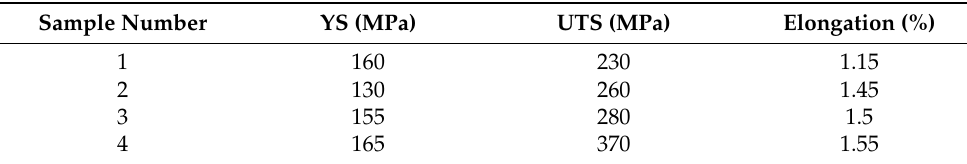
Figure 12. Stress–displacement curve of welded joints of the four samples. Table 3. Tensile test results of the welded joints of the four samples.